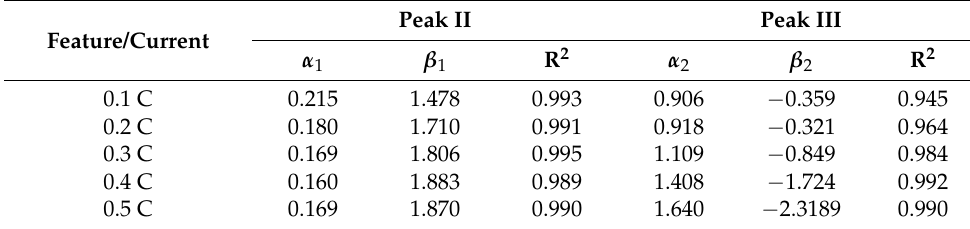
Table 2. The coefficients α i and β i with different currents. Feature/Cur-